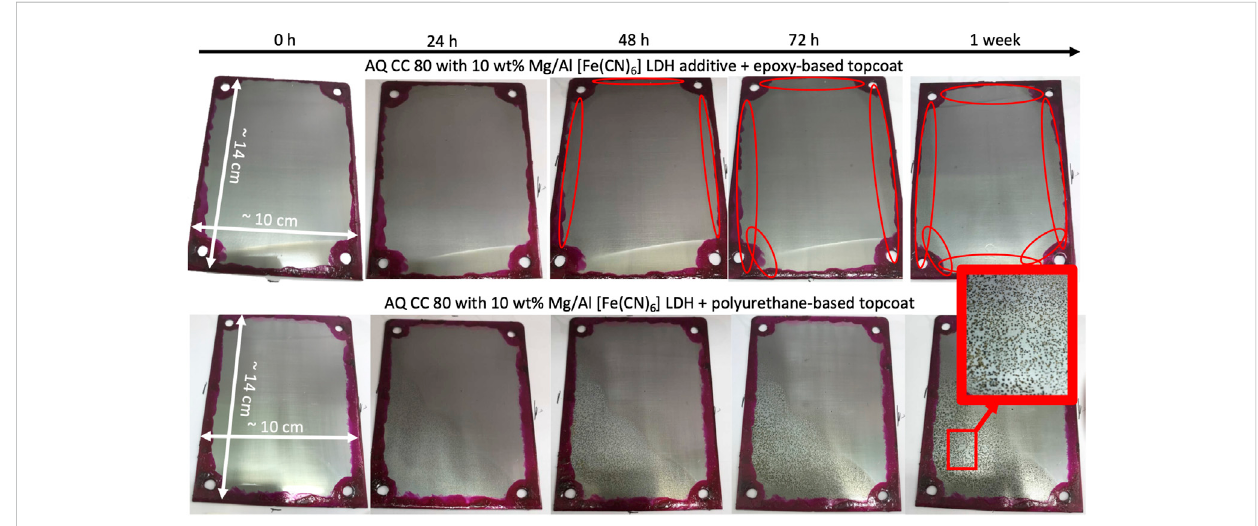
FIGURE 12 Salt spray test results for the carbon steel plates coated with multilayer coating systems with 10 wt% Mg-Al/[Fe(CN) 6 ] LDH sensing